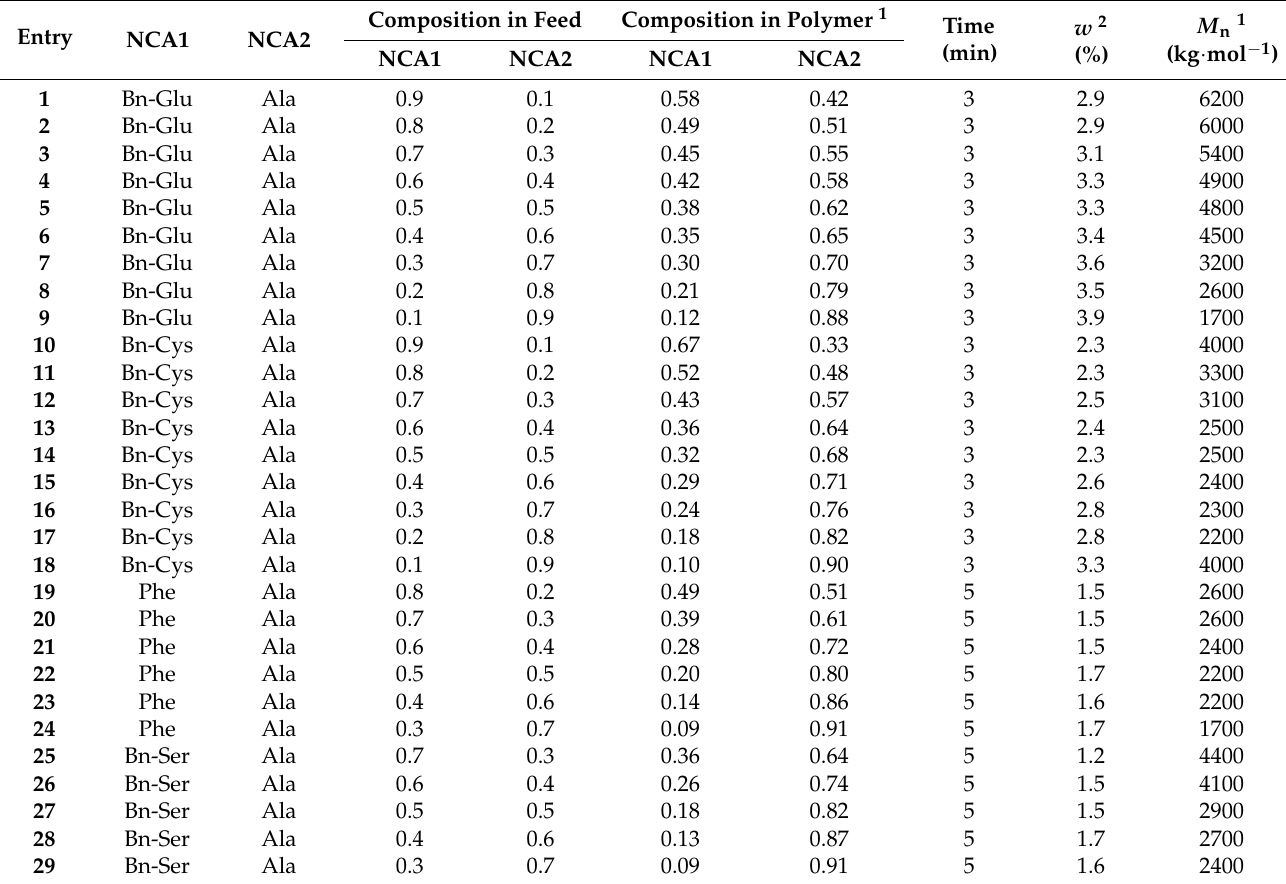
Table 1. Results of copolymerizations of Ala NCA with Bn-Glu NCA, Bn-Cys NCA, Phe NCA, and Be-Ser